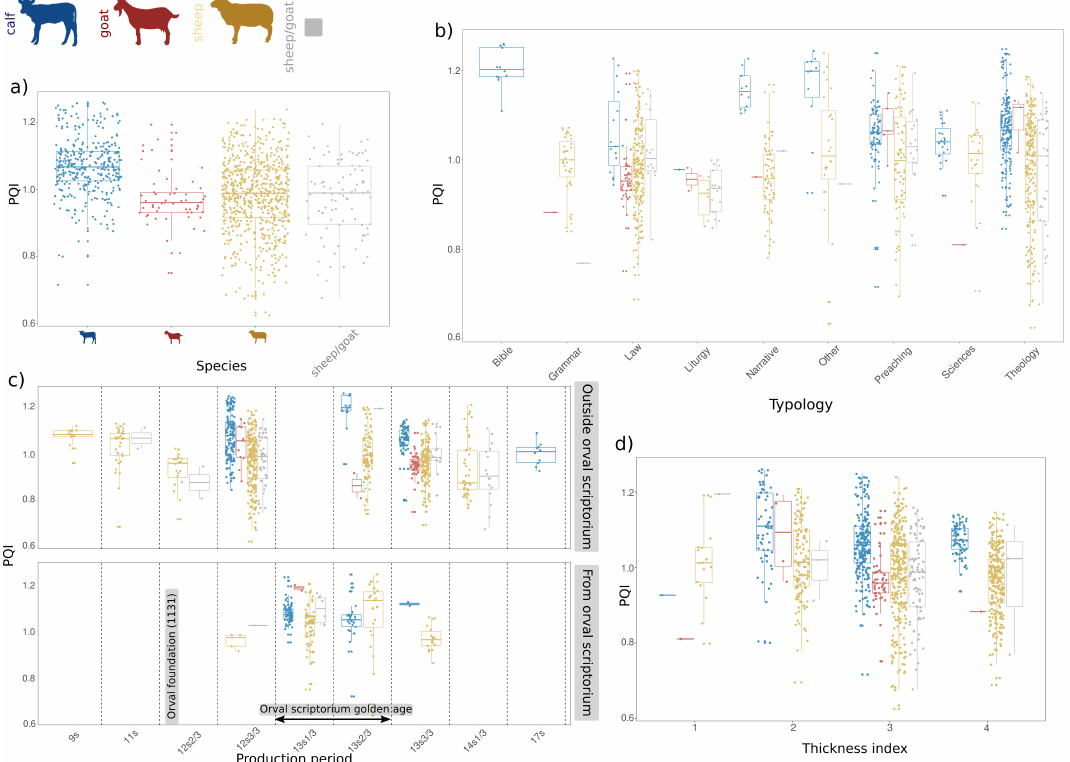
Figure 6. Plots depicting applications of PQI: a) Comparison of PQI against different species used for the production of parchment depicting that manuscripts made out of calfskin were of better quality than the ones made with sheepskin or goatskin. b) Comparison of PQI against different typology the parchments were used for. Biblical manuscripts were written on calfskin, having the highest PQI, which is in accordance with the findings in (Ruffini-Ronzani et al., 2021). Sheepskin was commonly used to produce grammar and theology texts with an intermediate deamidation index. c) Comparison of PQI against production period for parchment locally produced in Orval scriptorium (bottom panel) and for imported parchments (top panel) starting from 9th century until 17th century. The timeline is organised by thirds of a century (early, mid, and late).